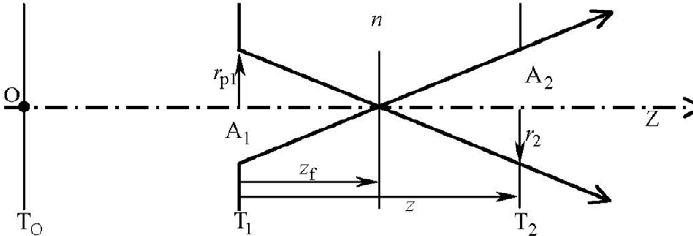
to trans- 1 . As z in- 2 2